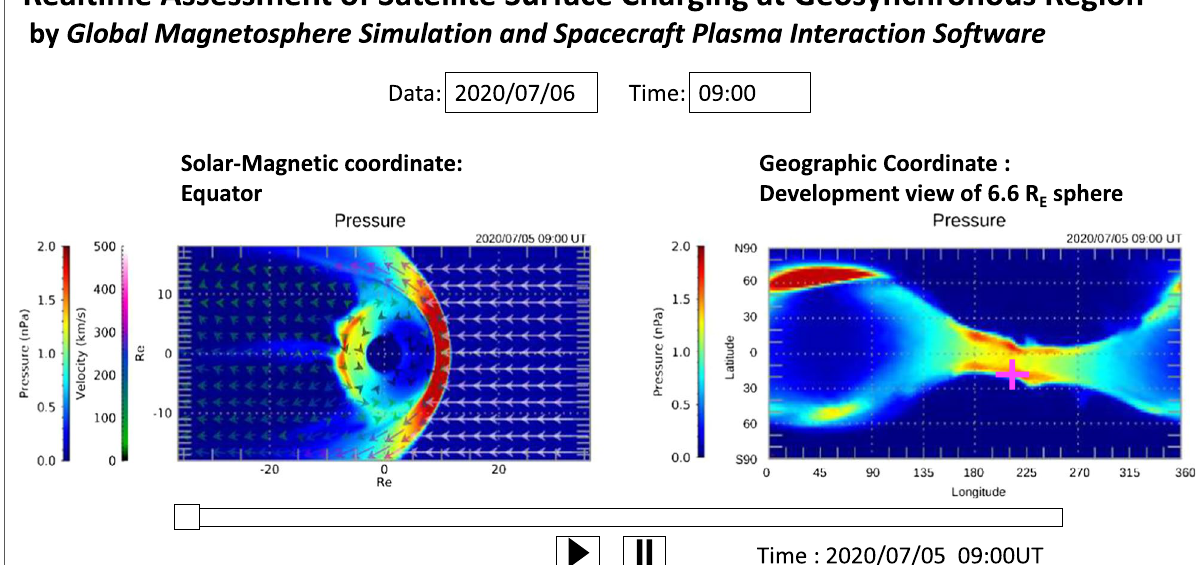
Fig. 7 Schematic snapshot of the web viewer of the system taken at 09:00 UT on July 05, 2020. At present, the viewer is only in Japanese. The left panel shows the pressure and bulk flow velocity distributions on the equatorial plane in the SM coordinate system. The right panel shows the pressure distribution on the 6.6 R E sphere in the geographic coordinate system. Specific date and time can be selected at the top column. A 2‑h movie from the selected start time in the right panel can be played by controlling the bottom slider. The pink cross mark on the right panel of Fig. 7 can be moused over to examine the parameters and estimated satellite potentials. The result is instantaneously shown in the table inside the viewer. A schematic table is separately shown in Table 1